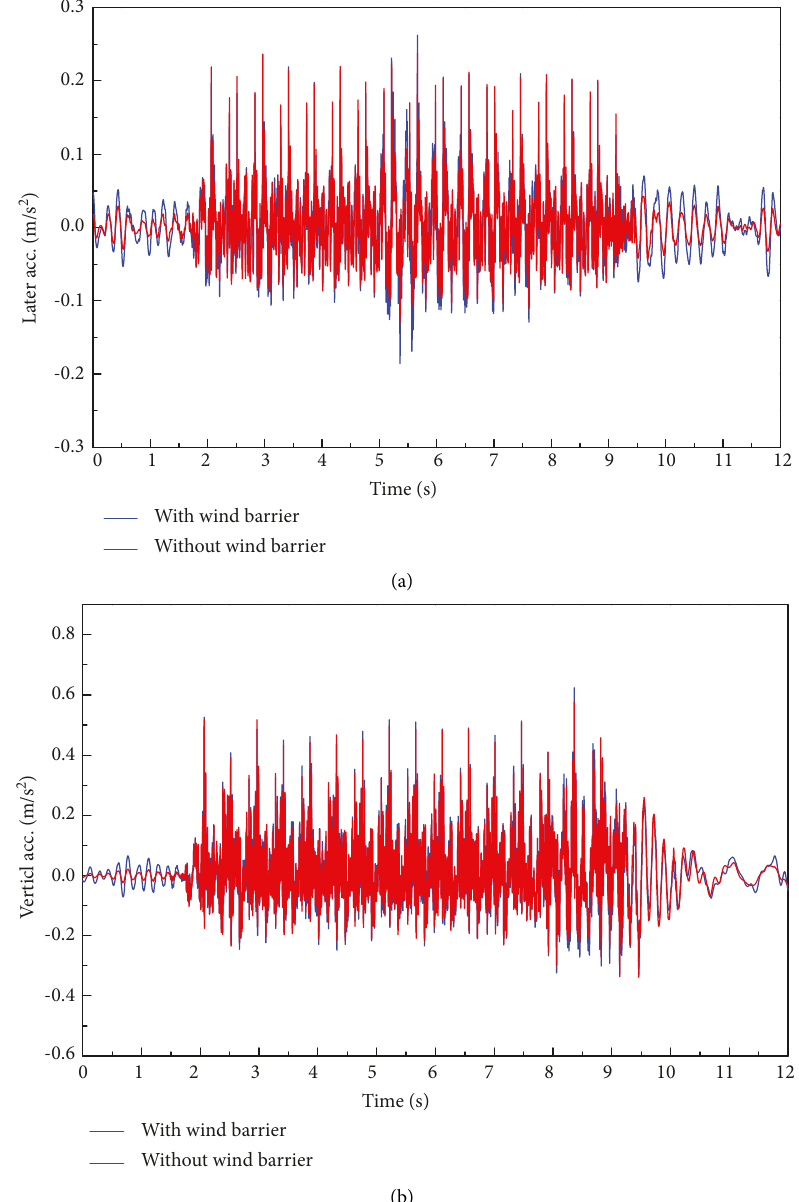
Figure 14: Acceleration time histories of node B138 with/without wind barrier. (a) Lateral acceleration. (b) Vertical